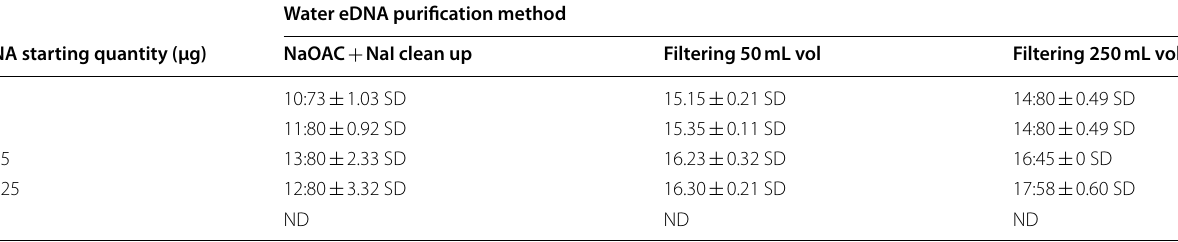
ND not detected